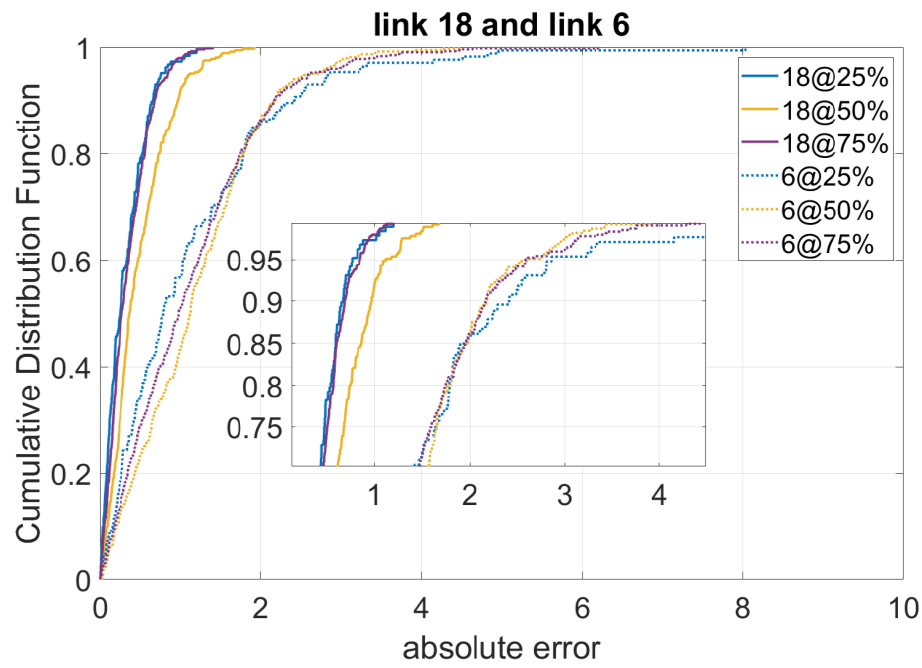
Figure 3. Performance of the Algorithm for Links with Highest p-Score and Lowest p-Score.